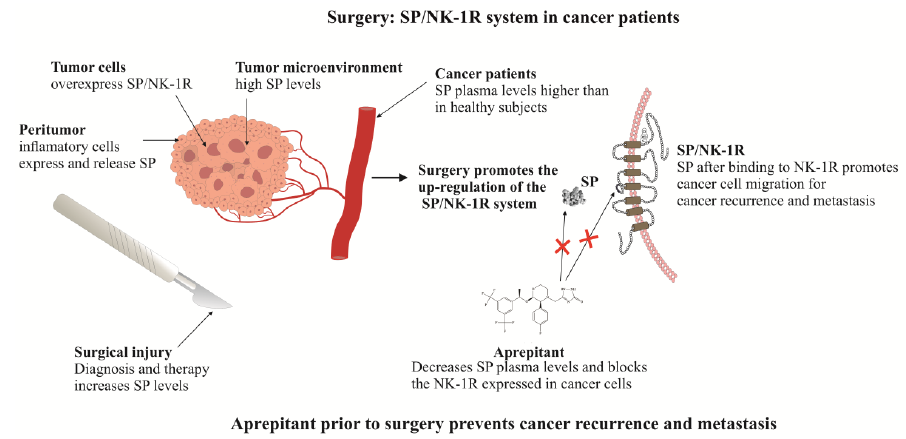
Figure 1. Surgery in cancer patients and the use of aprepitant to prevent cancer recurrence and